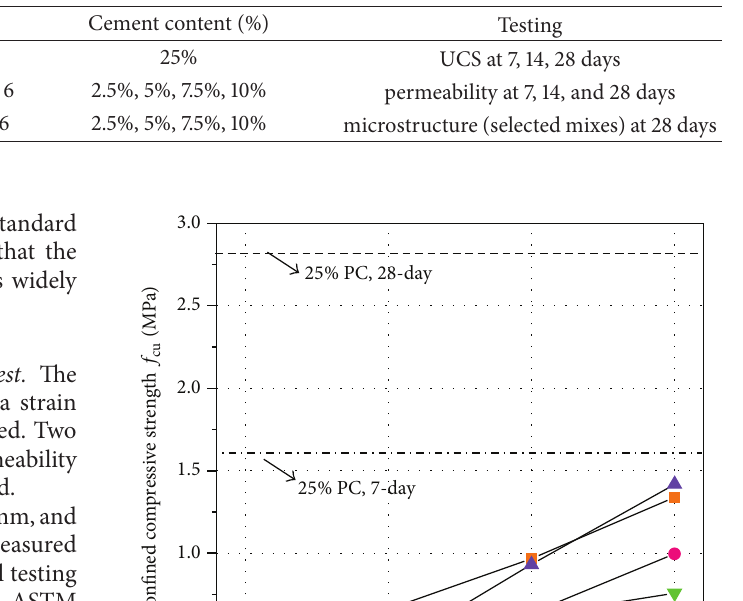
(MPa) and cement contents (%) cu